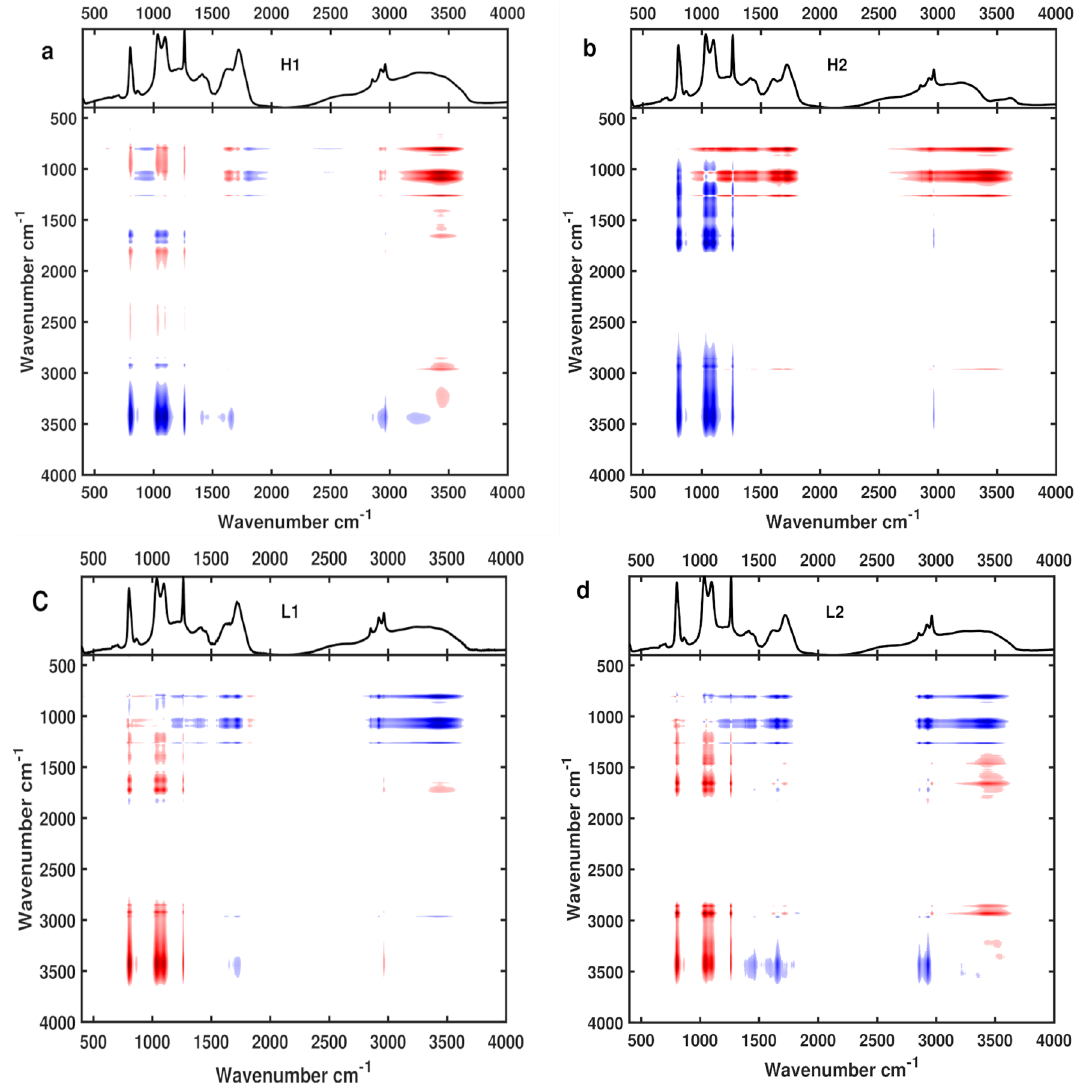
Figure 4. 2D COS showing asynchronous spectra for the four samples. Spectra were produced following Noda 2016 & 2017. Iron concentration is used as the perturbation with samples up to salinity 25. Panels a, b, c, and d, represent H1, H2, L1, and L2,